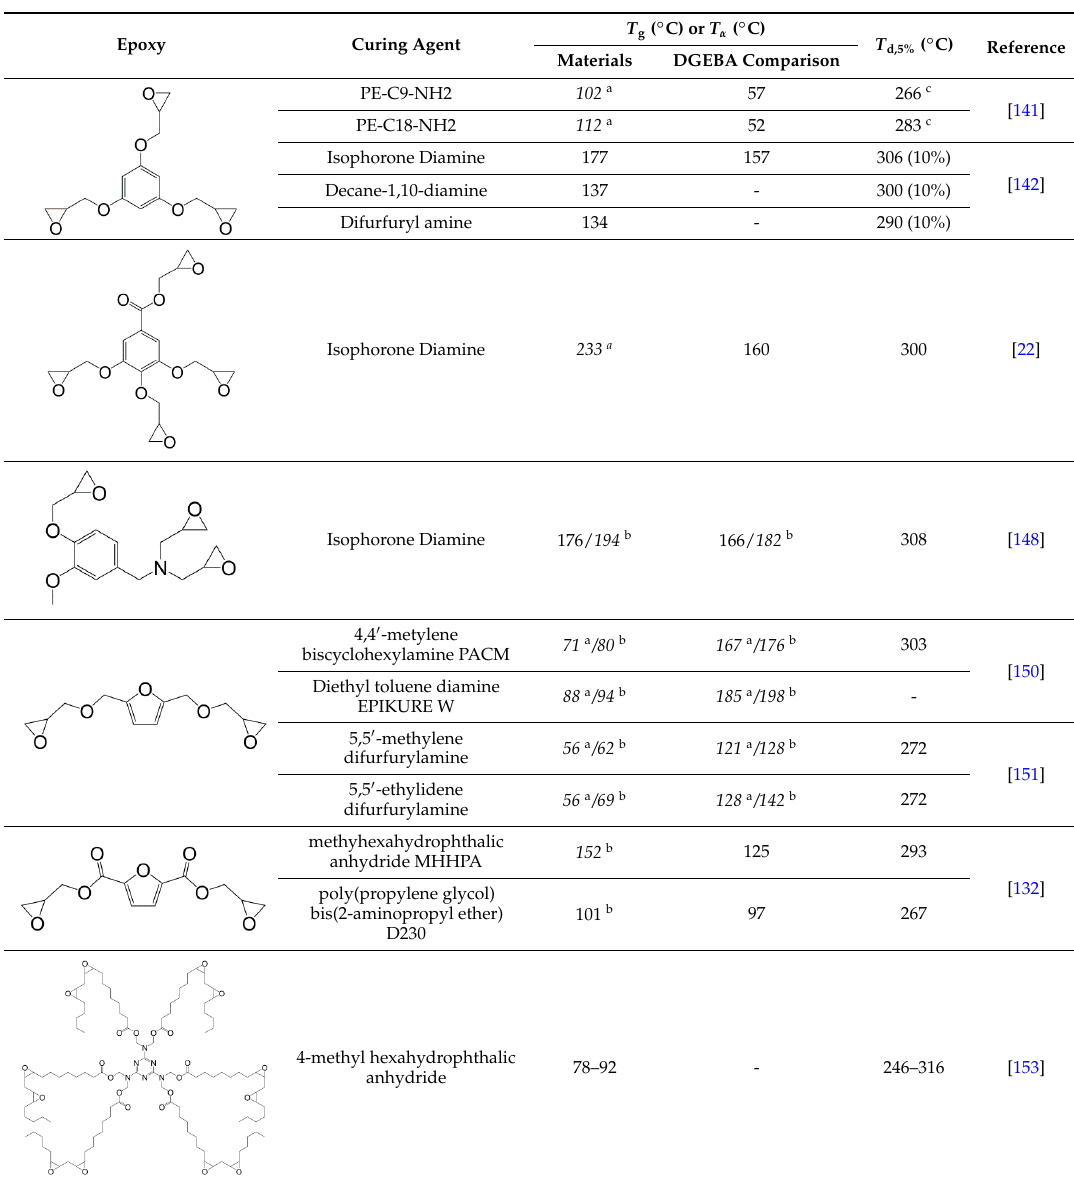
Table 2. Mono-aromatic, poly-epoxy resins and thermal properties of the cured materials. T g values are indicated in plain text, T α are in italics.